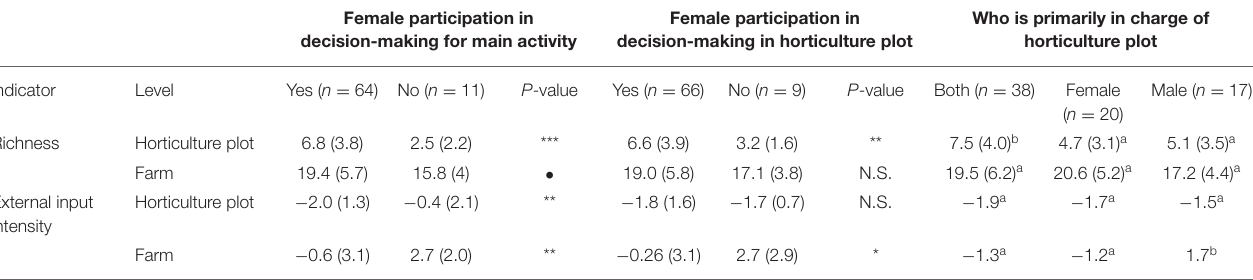
TABLE 1 | Relationship between agrobiodiversity and indicators of women’s empowerment. Reported values are means followed by standard deviation in parenthesis. Female participation in Female participation in Who is primarily in charge of decision-making for main activity decision-making in horticulture plot horticulture